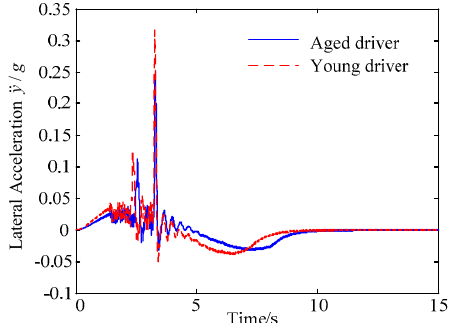
ff erent handling